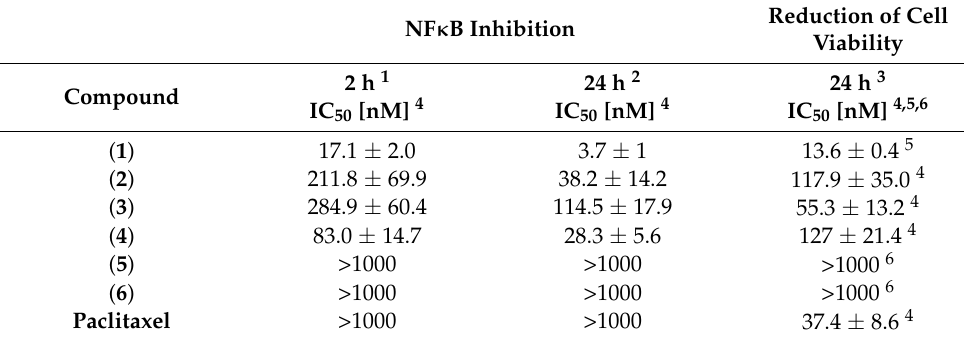
Table 1. IC 50 -values determined for NF κ B inhibition and reduction of cell viability. Figure 2. PAs inhibit NFκB - dependent gene transcription. The NFκB -dependent luciferase activity was quantified 2 h post- stimulation of NFκB -MDA-MB-231-nanoluc cells. Compounds ( 1 )–( 6 ) were applied at a concentration ranging from 1000 nM to 0.06 nM before being stimulated for 2 h with 20 ng/mL TNFα. In each individual experiment, the NFκB -dependent luminescence was normalized to the lowest concentration applied (100%). Each data point represents the mean of at least three independent experiments. Table 1. IC 50 - values determined for NFκB inhibition and reduction of cell viability.